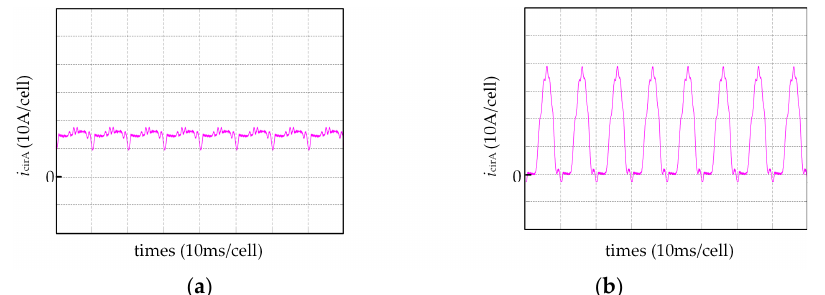
Figure 14. Simulated waveform of the circulating current fluctuation at cos φ = 0.954 ( N = 8). ( a ) The proposed modulation method, ( b ) the conventional modulation method.